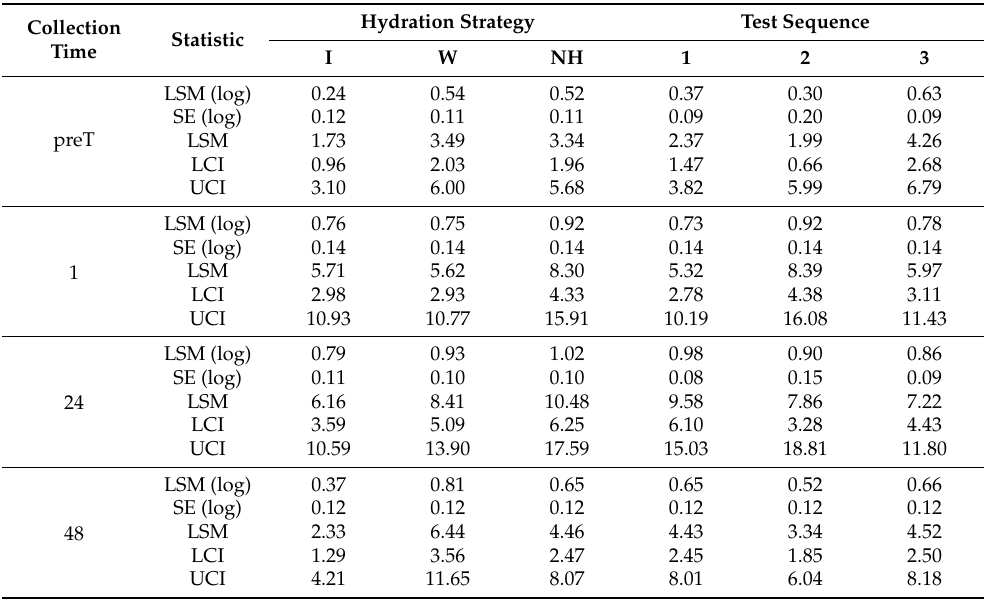
Table 16. Results for interleukin 1 β [pg · mL − 1 ] measured before the test (preT) and 1, 24, and 48 h after the test performed for different hydration strategies in three consecutive tests: marginal means (LSM); standard errors (SE) for values after logarithmic transformation (log); and marginal means and upper (UCI) and lower (LCI) confidence intervals restored to original